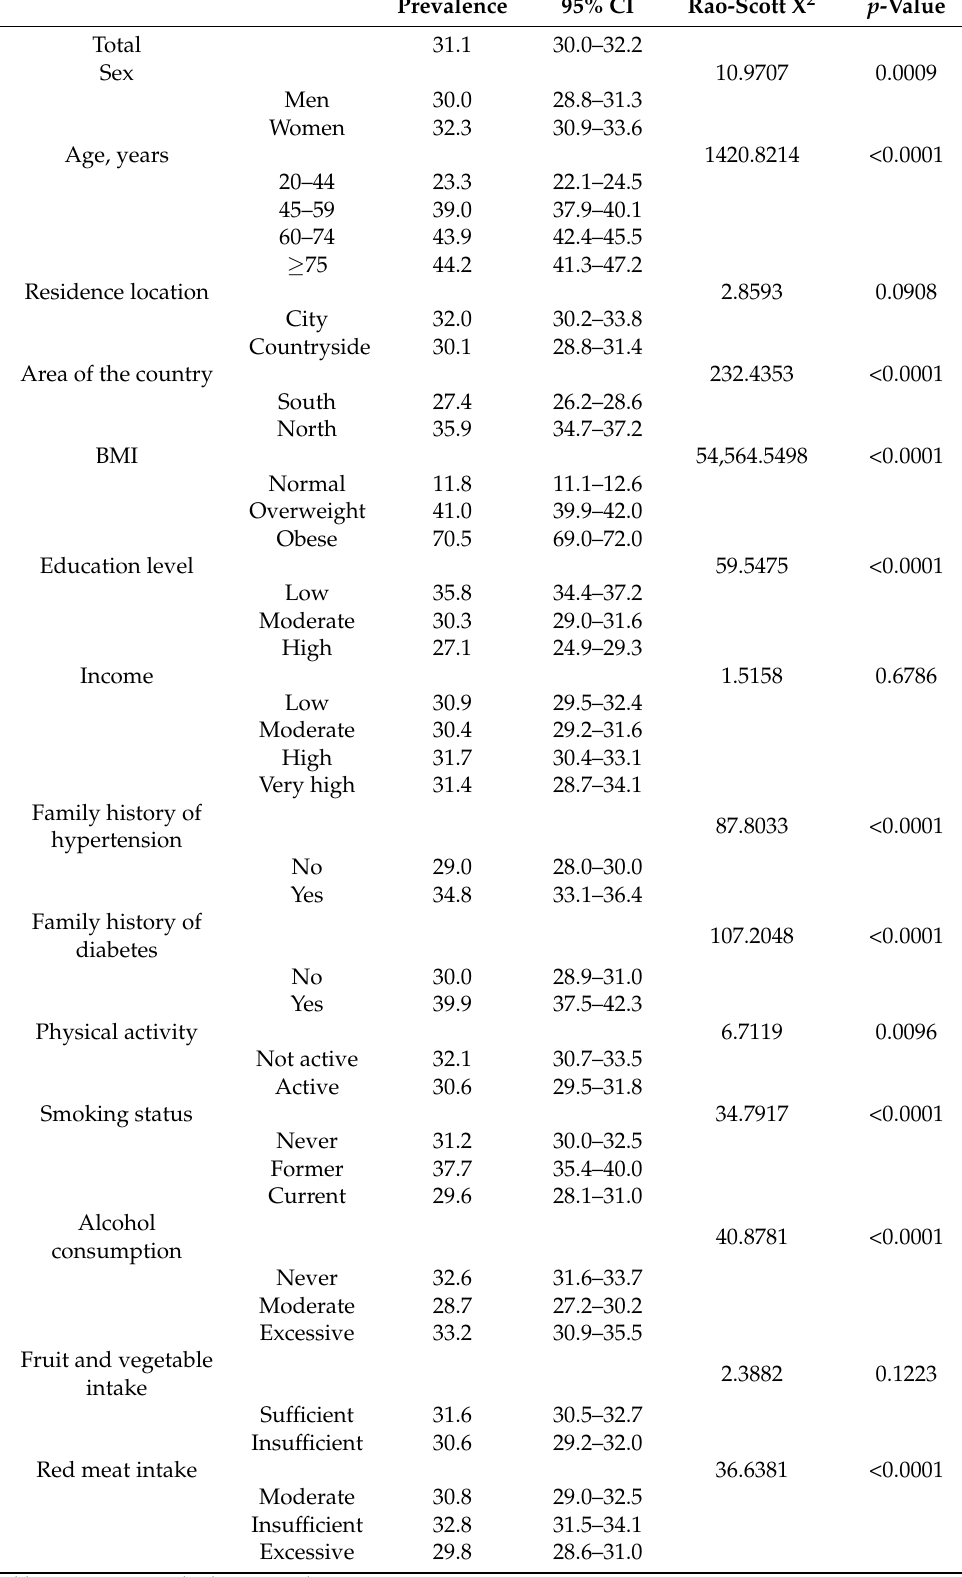
Table 2. Prevalence of metabolic syndrome in adults according to participant